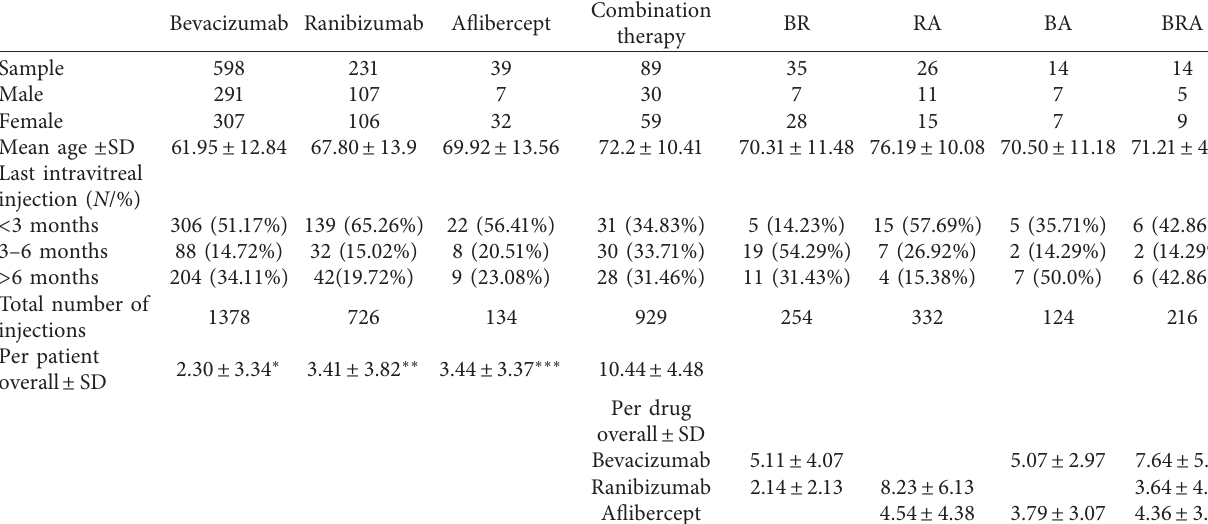
Table 1: General demographic data.